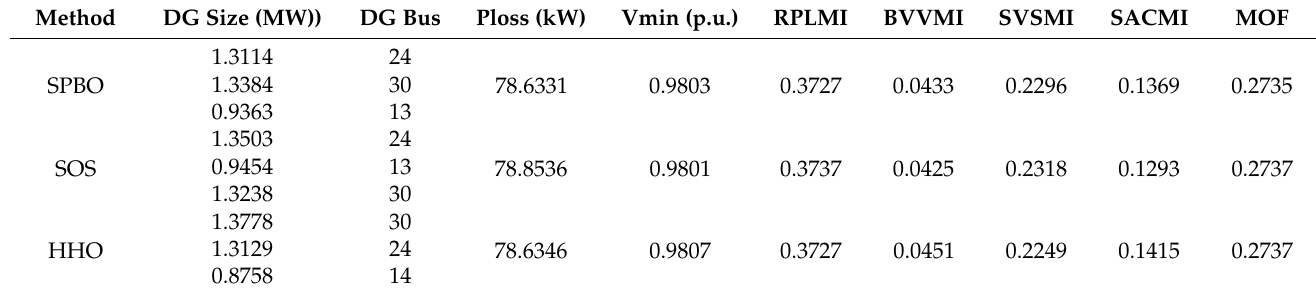
Table 5. Comparison of results for exclusive PV-DG allocation (case-3) for 33-bus test system.